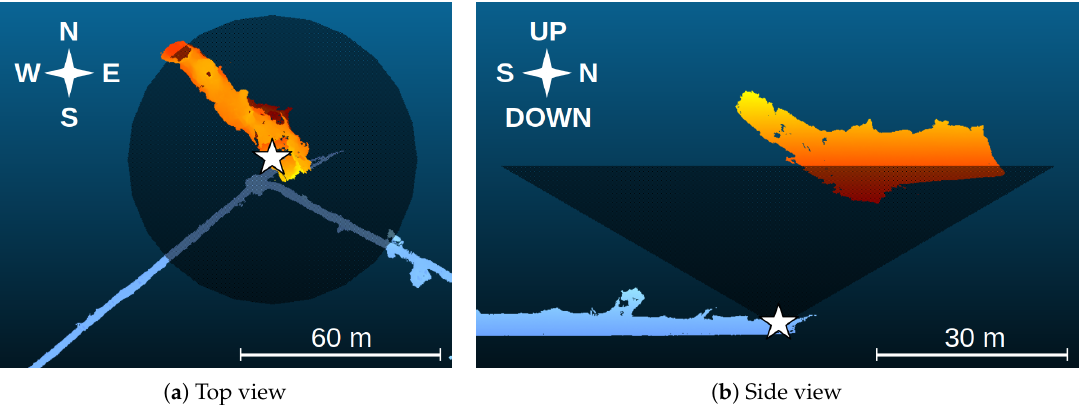
Figure 3. Maps of both the Temperino mine (blue) and the Gran Cava (red). The detector position is marked with the white star, and the acceptance cone ( ± 60 ◦ from the vertical direction) is represented by the dark area up to a height of about 25 m. For the sake of clarity, the outline of the hill is not